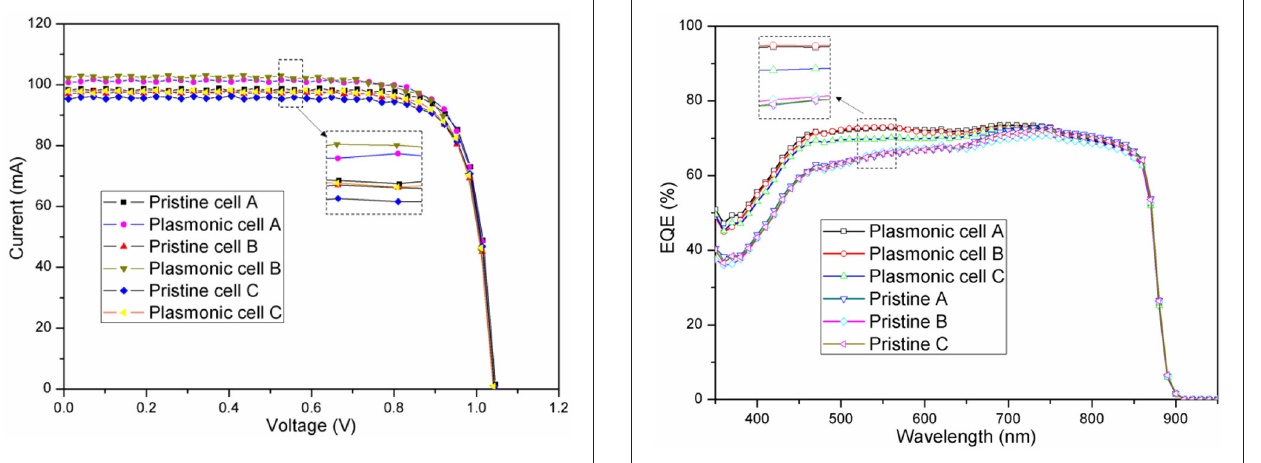
FIGURE 6 | Photovoltaic I-V curves for the S-J GaAs solar cells under AM1.5 illumination.